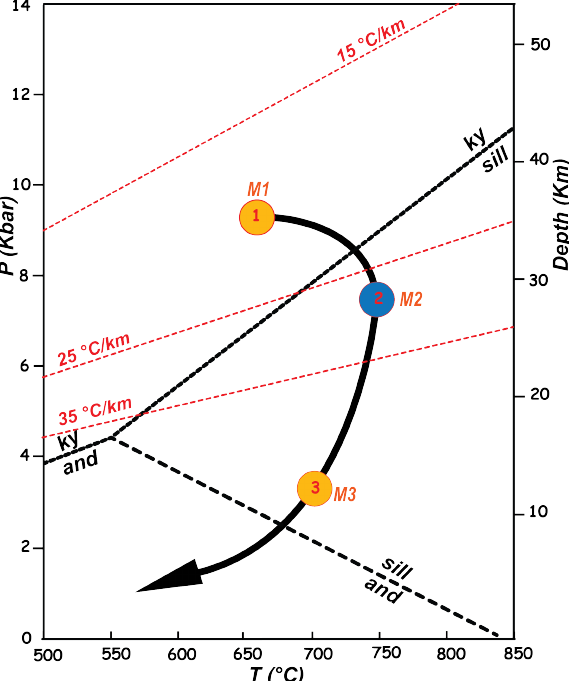
Figure 11. Metamorphic P-T path of the migmatitic paragneisses of the Filali unit. The P-T conditions demonstrate that the migmatitic paragneisses underwent three major tectonic metamorphic events, MP-MHT (M1), MP-HT (M2), and LP-HT (M3). The semitransparent circles, marked with num- bers, refer to the P-T conditions of the early metamorphic peak, syn-thermal peak, and retrograde assemblages. The obtained retrograde path suggests a clockwise P-T path and a sub-isothermal decompression followed by cooling. See text for further